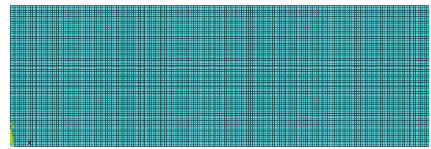
Figure 6: Wrinkling pattern scanning.